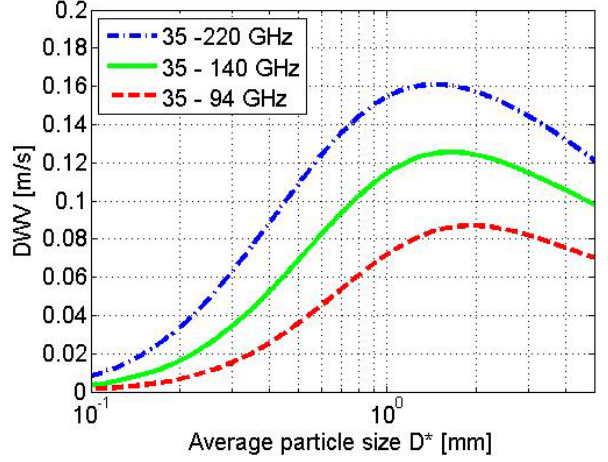
Figure 11. Difference in mean Doppler velocity as a function of average particle size computed for various wavelength